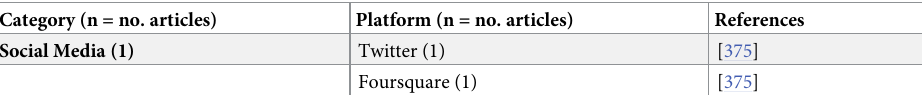
Table 27. Number of articles predicting social class, with associated platforms and references.